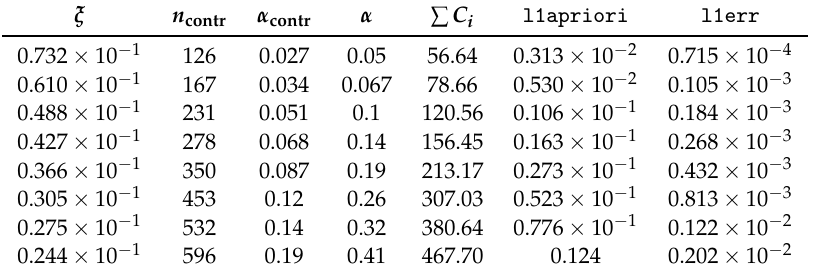
Table 1. Summary of the L 1 bounds on the approximation error obtained for the range of noises ξ , where n contr and α contr are chosen in order to satisfy Equation (6) so that the values α and ∑ C i obtained through Lemma 1 attempt to minimize the error l1err obtained through the algorithm in [13]. n